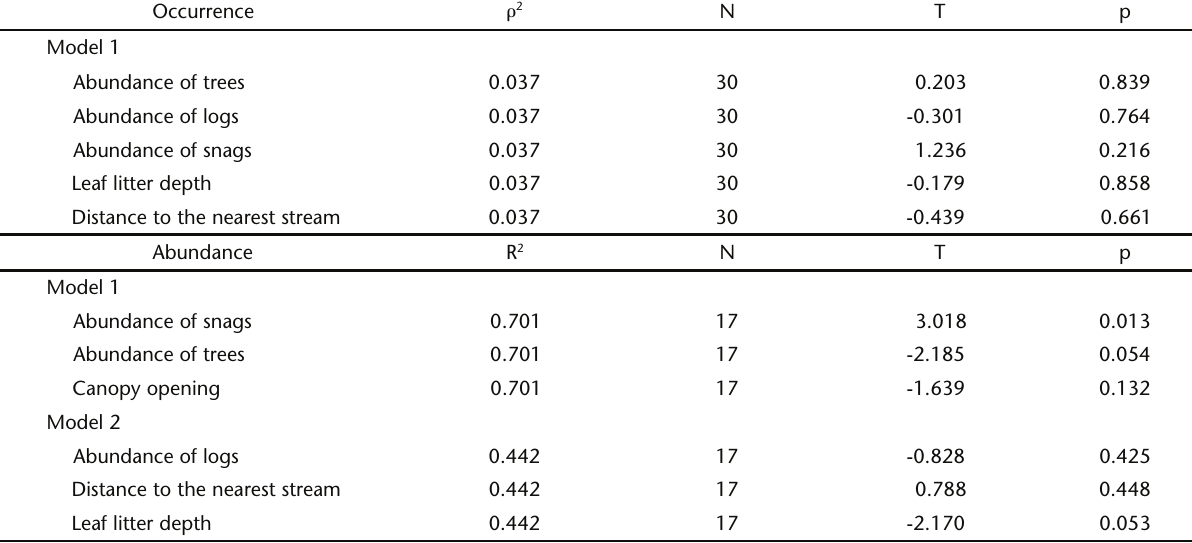
Table VII. Results of the multiple logistic regression for frequency of use (occurrence) of different sites in the forest by M. watsonii (categorical variable 0 = owl absent, 1 = owl present) and results of the multiple linear regression for owl's abundance in relation to the forest structure components and features of